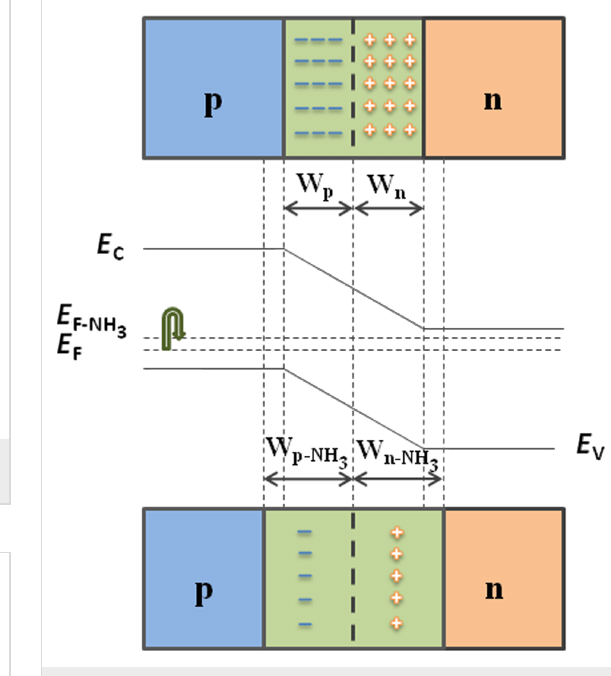
Figure 10: Schematic of p–n junction of In 2 O 3 /PANI nanofibers and its potential energy barrier change when exposed to NH 3